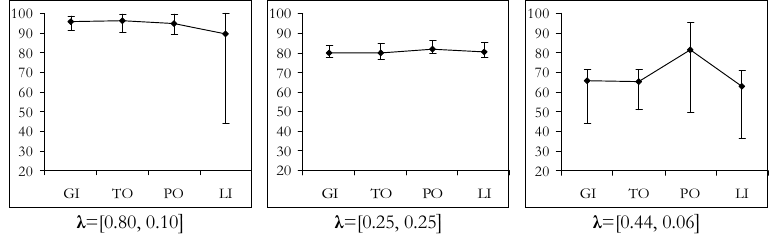
Figure 5 – Mean value (dot) and range of p , computed across the 25 combinations of discretization types, obtained by the MGM - FA study applied to the “non-block” data sets with λ =[0.25, 0.25] (left- hand side), λ =[0.80, 0.10] (centre), λ =[0.44, 0.06] (right-hand